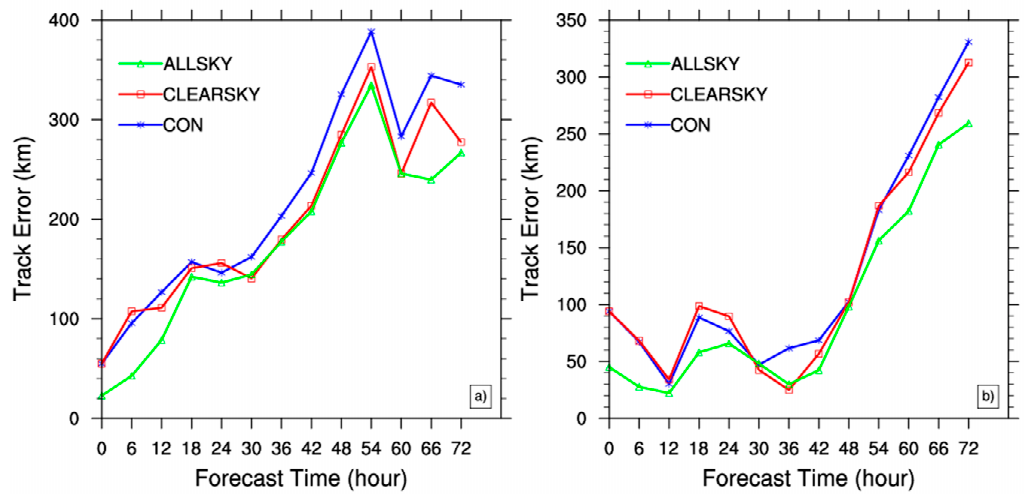
Figure 9. 72-h forecast track errors (experiment data minus best-track data, km) from CON (blue), CLEARSKY (red), and ALLSKY (green) experiments for ( a ) Chan-hom and ( b )Nangka, starting from 1800 UTC 9 July Central sea-level pressure (CSLP) errors of 72-h forecasts of Chan-hom and Nangka are given in